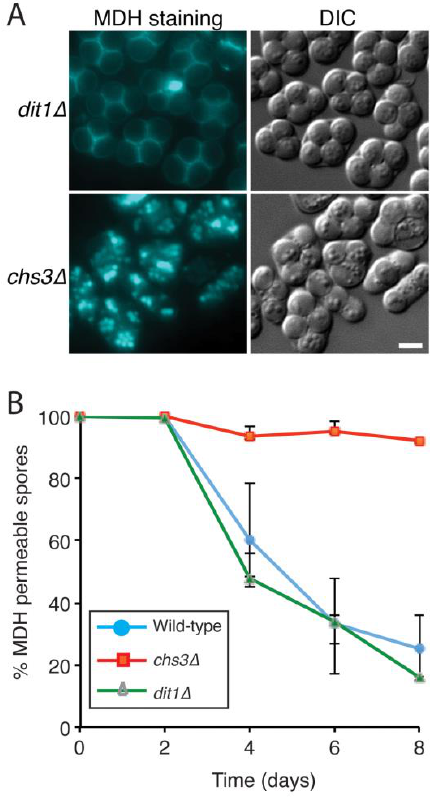
Figure 2. The outer spore wall is required for impermeability to MDH. ( A ) Asci formed by dit1 ∆ (AN264) or chs3 ∆ (AN262) diploids after incubation on SPO plates for eight days were stained with MDH and observed by fluorescence (blue staining) and light microscopy. Scale bar = 3 microns. ( B ) Time course of MDH staining wild-type (AN120), dit1 ∆ (AN264), and chs3 ∆ (AN262) strains were sporulated on SPO plates and at two day intervals, spores were stained with MDH and the percentage of spores showing MDH staining of lipid droplets within the spore was determined. 500 spores were scored at each time point for each strain. Error bars indicate the range of values obtained at each time point over three separate experiments.